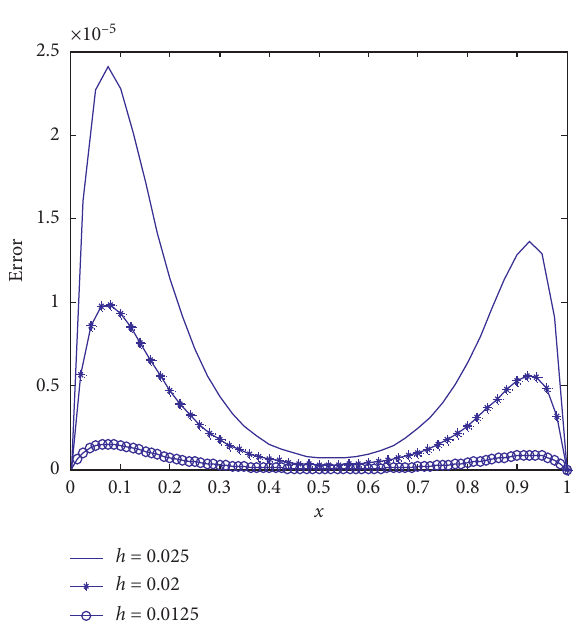
Figure 6: The point-wise absolute errors of Example 1 for different values of mesh size h, ε � 2 − 8 , and δ � 0 . 5 ε